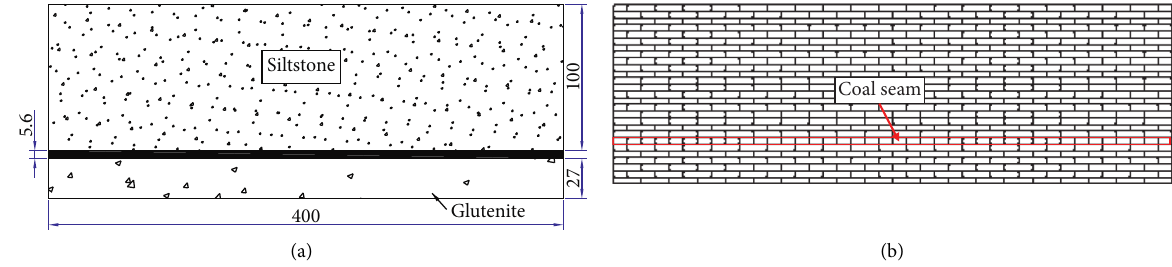
Figure 5: Coal mining model diagram of the lower group. (a) CAD design drawing. (b) UDEC model diagram.